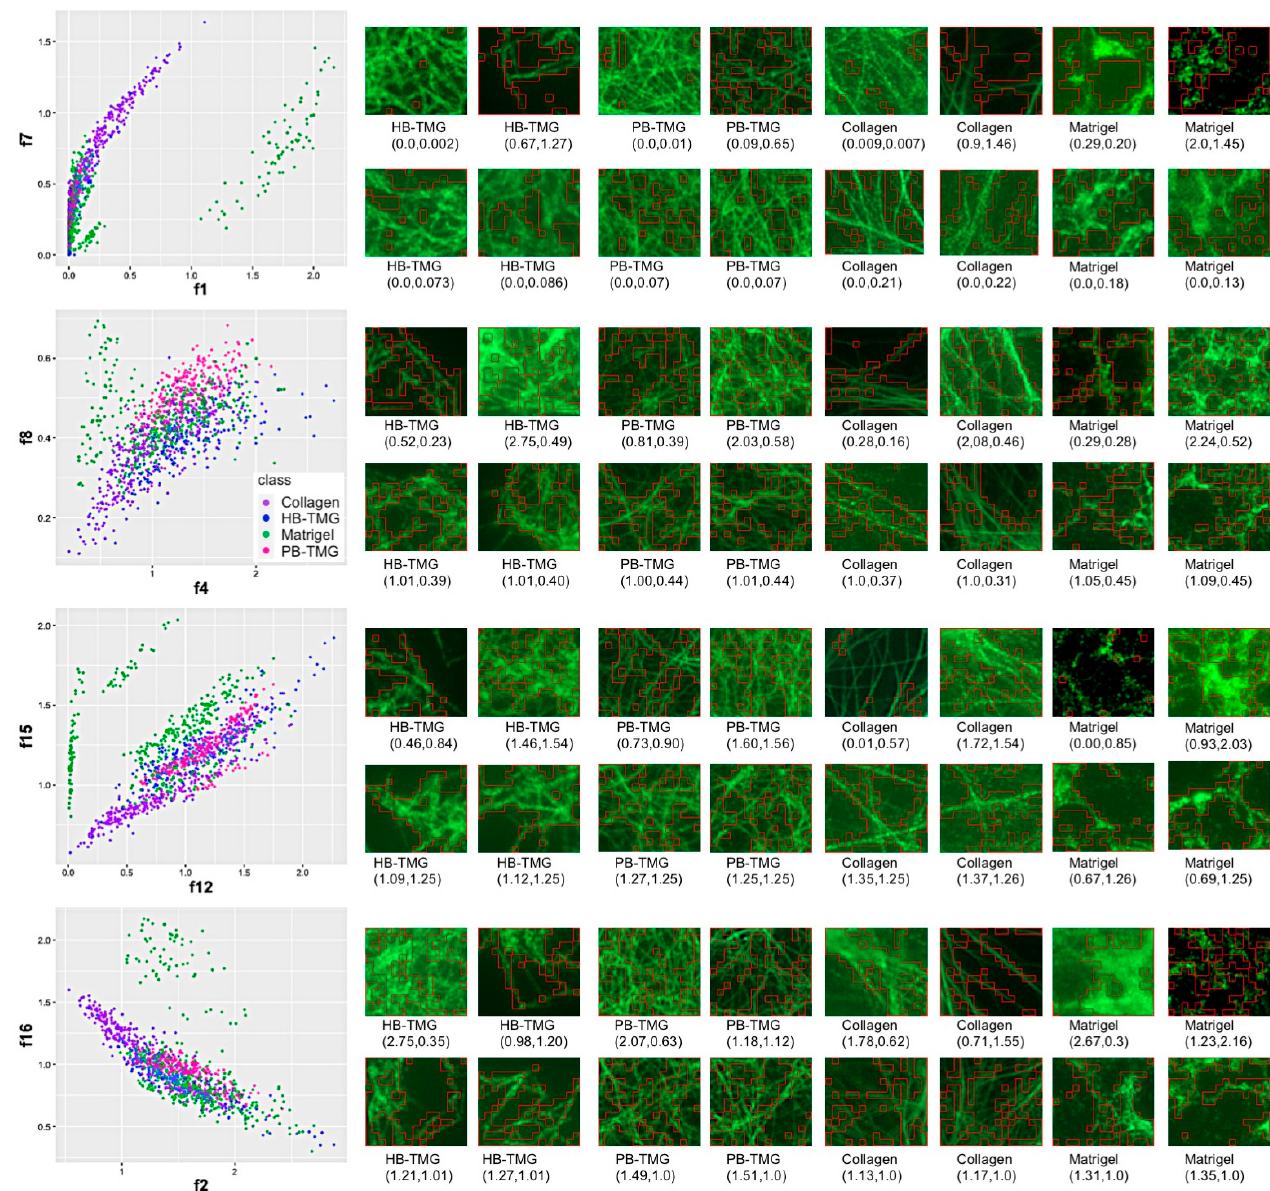
Figure 3. Machine learning analysis of microstructural distinctions between the different native ECM hydrogels. Four groups of figures are presented. Each group contains a scatter plot of learned features and 16 tiles with feature highlights of four kinds of IF staining images. The top eight images represent the features of maximum and minimum values selected from the left plot. Additionally, the bottom images represent features of similar values. Values under each image are the corresponding values in the left